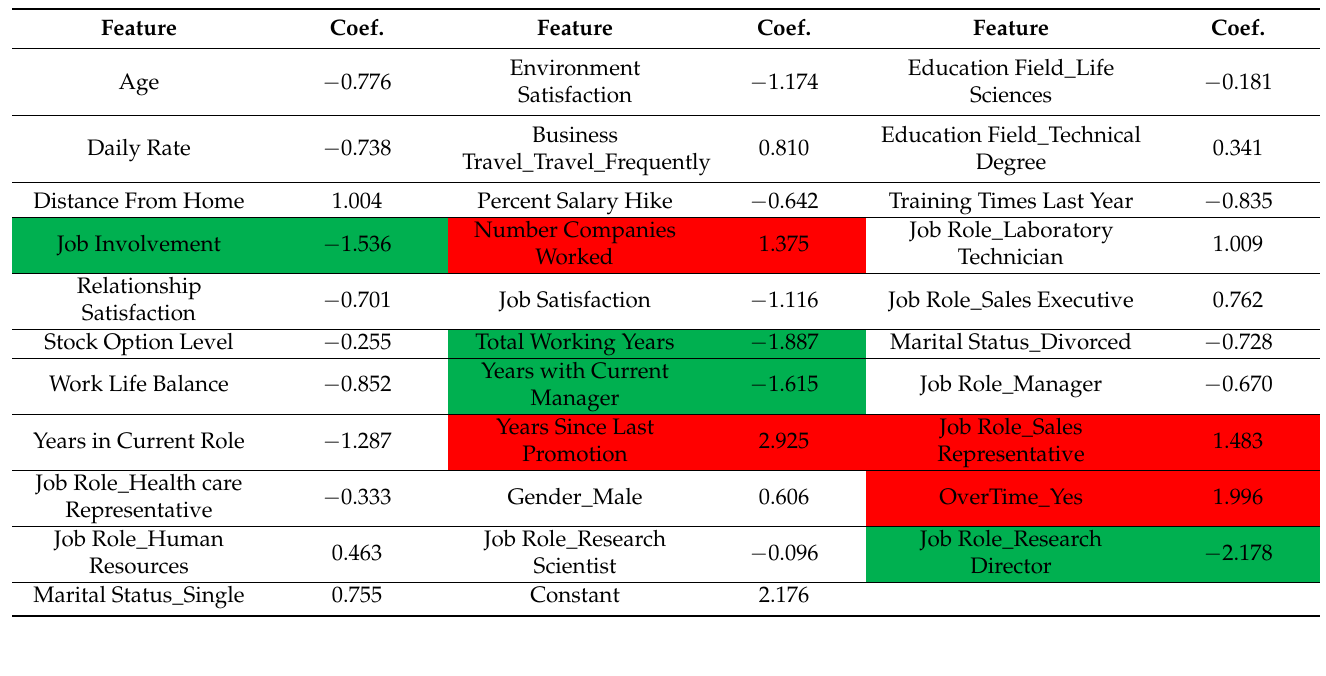
Table 3. Final Model Logistic Regression Coefficients. Green cells are the most important features that contribute to staying with company and red cells are the features that contribute to leave the company the most.